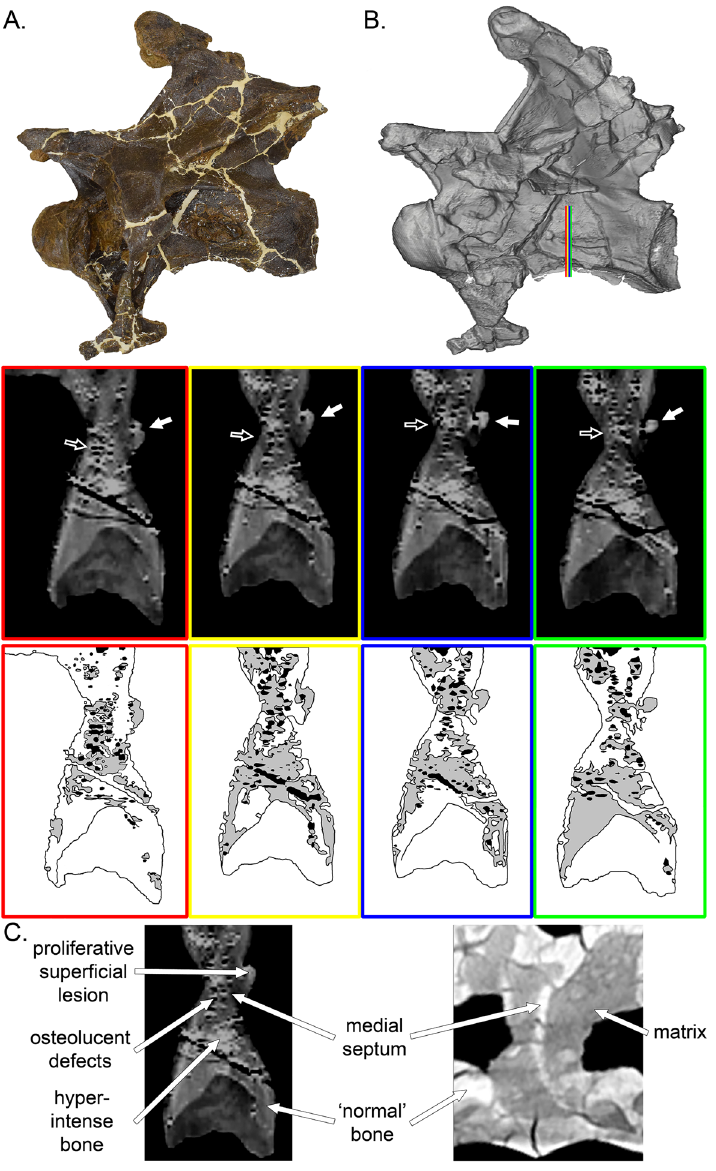
Figure 2. CT scans of cervical 7 of MOR 7029. Photograph and scan model of the vertebra (( A,B ) respectively). The colored lines in ( B ) correspond to the scan slices (and scan interpretative drawings below). White arrows point to the external feature, while black arrows denote the hyperintense bone and irregular voids. ( C ) Comparison of the abnormal tissue composition of MOR 7029 (left), compared to that of a ‘normal’ diplodocine (right). Text and white arrows indicate the various features different shared/differentiated between the two. For the interpretative drawings, white = ‘normal’ bone, grey = hyperintense bone, black = irregular